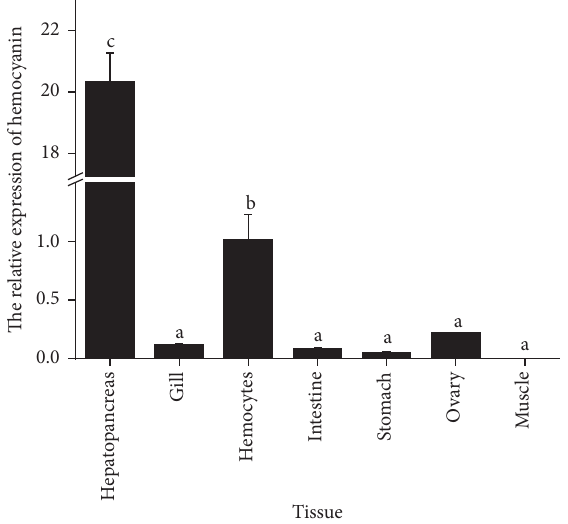
Figure 3: Quantitative real-time PCR analysis of hemocyanin expressionsinvarioustissuesof M.nipponense .The 𝛽 -actingenewas used as the internal control. Different letters in each index indicated significant differences ( 𝑃 < 0.05 ).